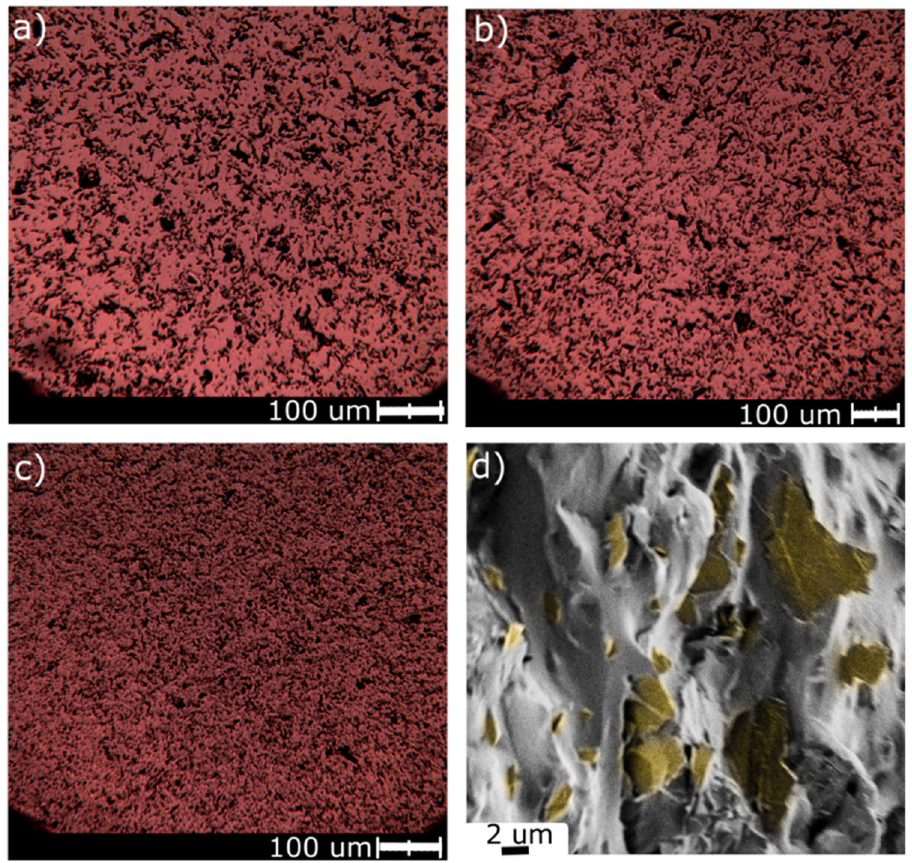
Figure 2. Polarizing-interference microscopy photographs of samples containing 10%wt graphene: ( a ) sample PDMS M (magnetic mixer stirring), ( b ) sample PDMS K (magnetic mixer stirring plus calendaring), ( c ) sample PDMS HPH (microfluidization), ( d ) a representative SEM scan of the PDMS/graphene nanocomposite sample (here: PDMS HPH). Yellow color refers to graphene